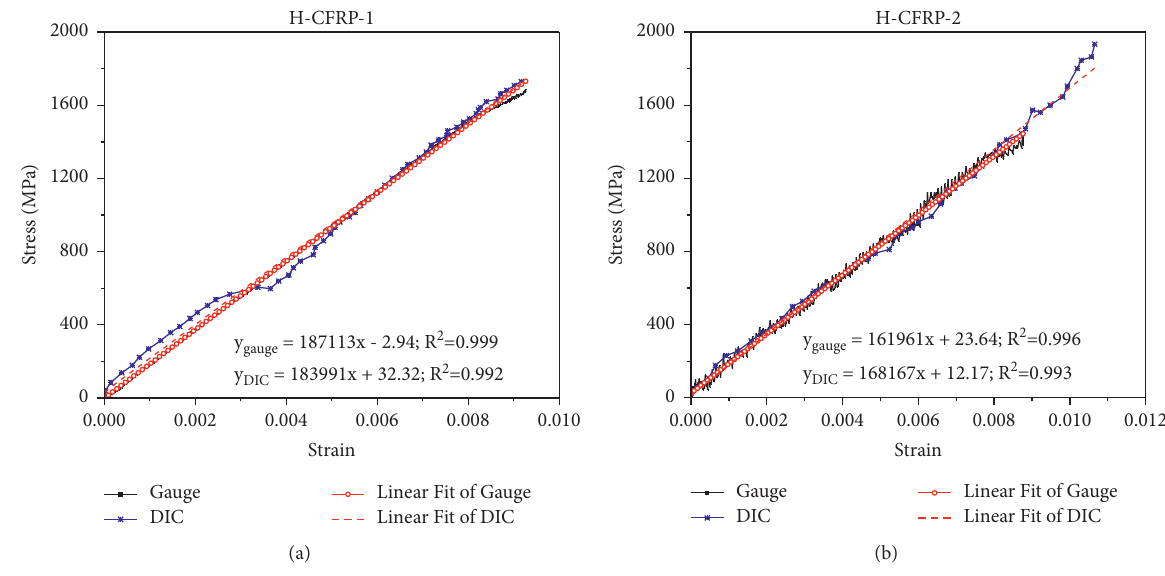
Figure 10: Stress-strain graph of H-CFRP grids. (a) H-CFRP-1. (b) H-CFRP-2. Table 5: Young’s modulus comparison of H-CFRP-1.